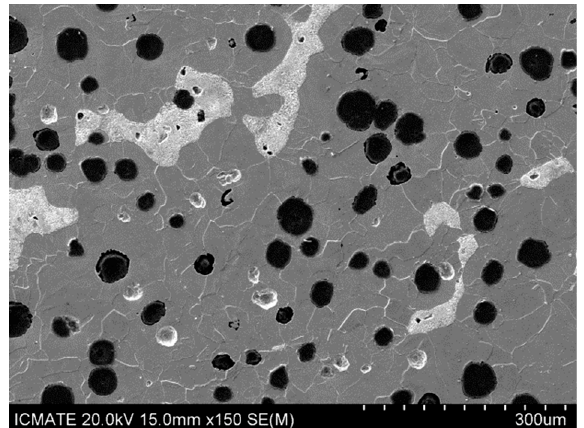
Figure 1. Scanning electron microscopy (SEM) micrograph with secondary electron imaging of GJS 400 produced with the Y 75 mm mould after etching with Nital 2%: nodular graphite (black) in the ferritic matrix with bright grain boundaries and pearlitic islands (light grey).